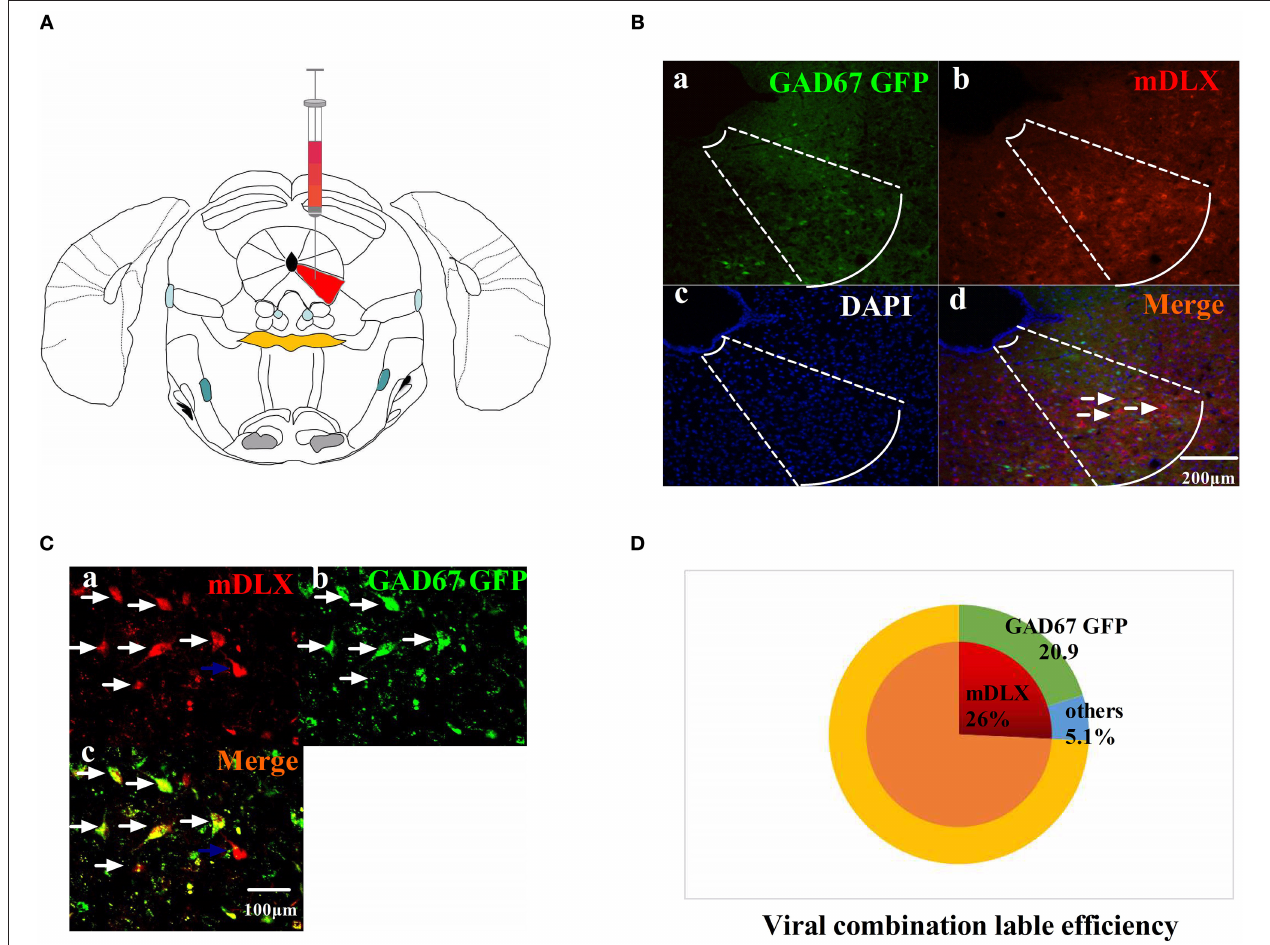
FIGURE 2 | The viruses combination cocktail label efficiency. (A) Pattern map of the viruses injection area. The red color region is the vlPAG. (B) The viruses combination cocktail was injected into the right side of the vlPAG of GAD67 GFP mice. (a) GAD67 GFP cells in the vlPAG (green). (b) Viruses-labeled cells (red). (c) DAPI nuclear staining (blue). (d) Colocalization fluorescence (pink), arrows show typical fluorescent, colocalized cells. Scale bar, 200 µ m. (C) High magnification images, scale bar, 100 µ m. White arrows indicate cells that are co-labeled, and blue arrows indicate cells that are mDLX-labeled but not labeled with GAD67 GFP. (D) Summary data show the percentage of colocalized cells in the area of total viruses-labeled cells. Red sector, viruses-labeled cells; green sector, GAD67 GFP cells; blue sector, viruses-labeled other cells. Data are expressed as the means ± SEM ( n = 3 mice in each